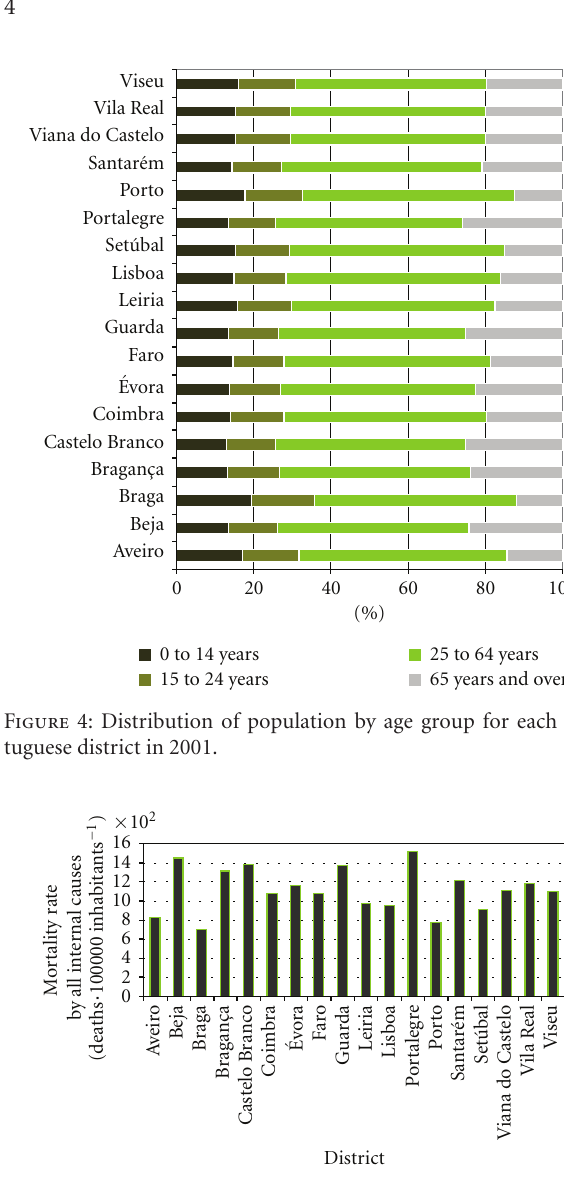
Figure 5: Annual mortality rate by all internal causes for each Por- tuguese district (deaths · 100000 inhabitants − 1 ) [46].